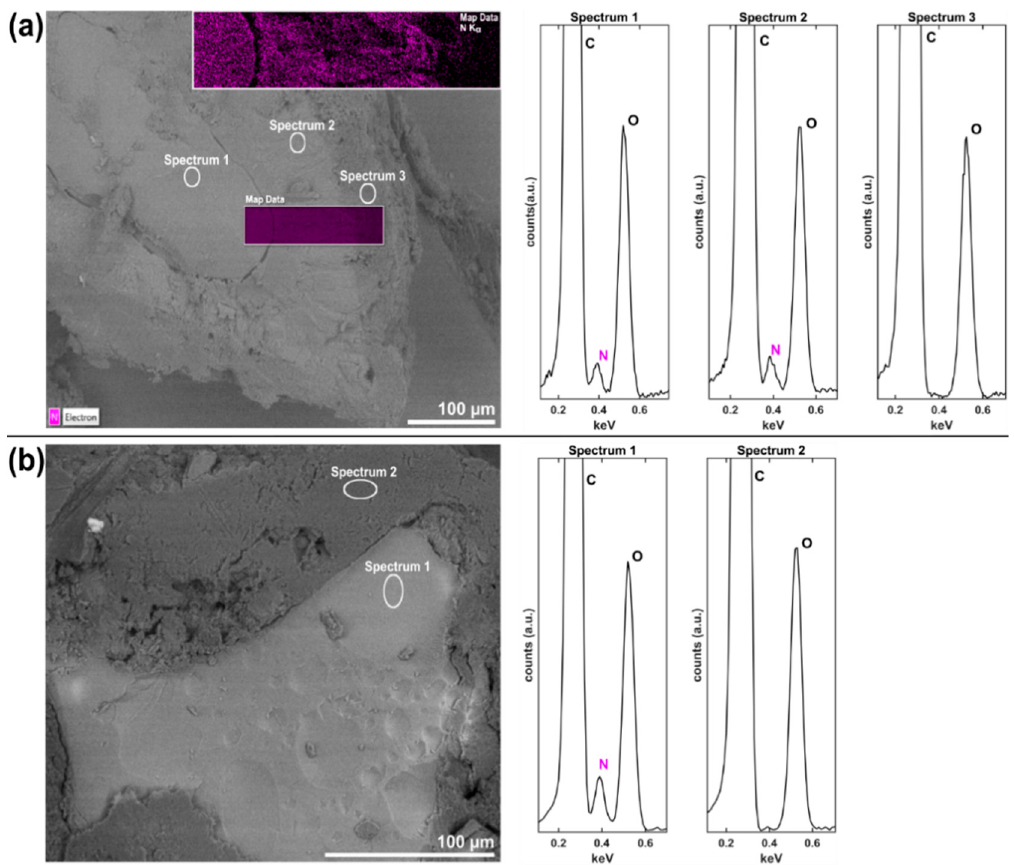
Figure 3. SEM cross-section images of coated amorphous CRV particles (20% ( w/w ) PS65) after 8 months of storage under ( a ) dry conditions at room temperature and ( b ) vacuum-sealed at − 20 °C. The distribution of CRV is illustrated by EDX elemental mapping of nitrogen in a representative mapping window (purple window in ( a )). The elemental composition at particle areas defined in ( a ) and ( b ) is shown in the EDX-spectra to the right of each